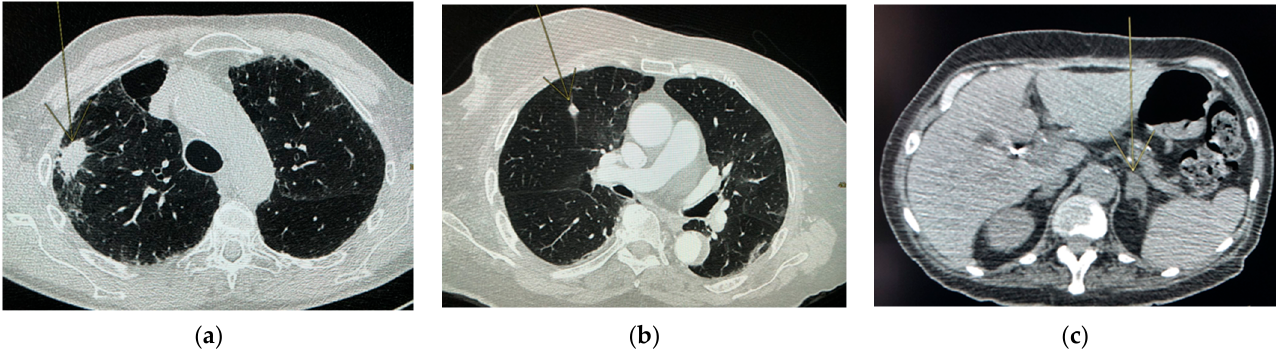
Figure 2. Suspicious mass and nodule. ( a ) Chest CT of an 81-year-old man performed in the context of suspected COVID-19 pneumonia with de novo discovery of suspicious mass. After biposing the lesion, the diagnosis is aspergilloma with usual interstitial pneumonia. Suspicious mass (> 3 cm) in the right upper lobe. ( b ) Chest CT of an 88-year-old woman performed in the context of suspected COVID-19 pneumonia, abdominal pain, nausea and vomiting with de novo discovery of suspicious nodule. Left lower lobe subpleural nodule. ( c ) Chest CT of a 62-year-old woman performed in the context of suspected COVID-19 pneumonia with de novo adrenal